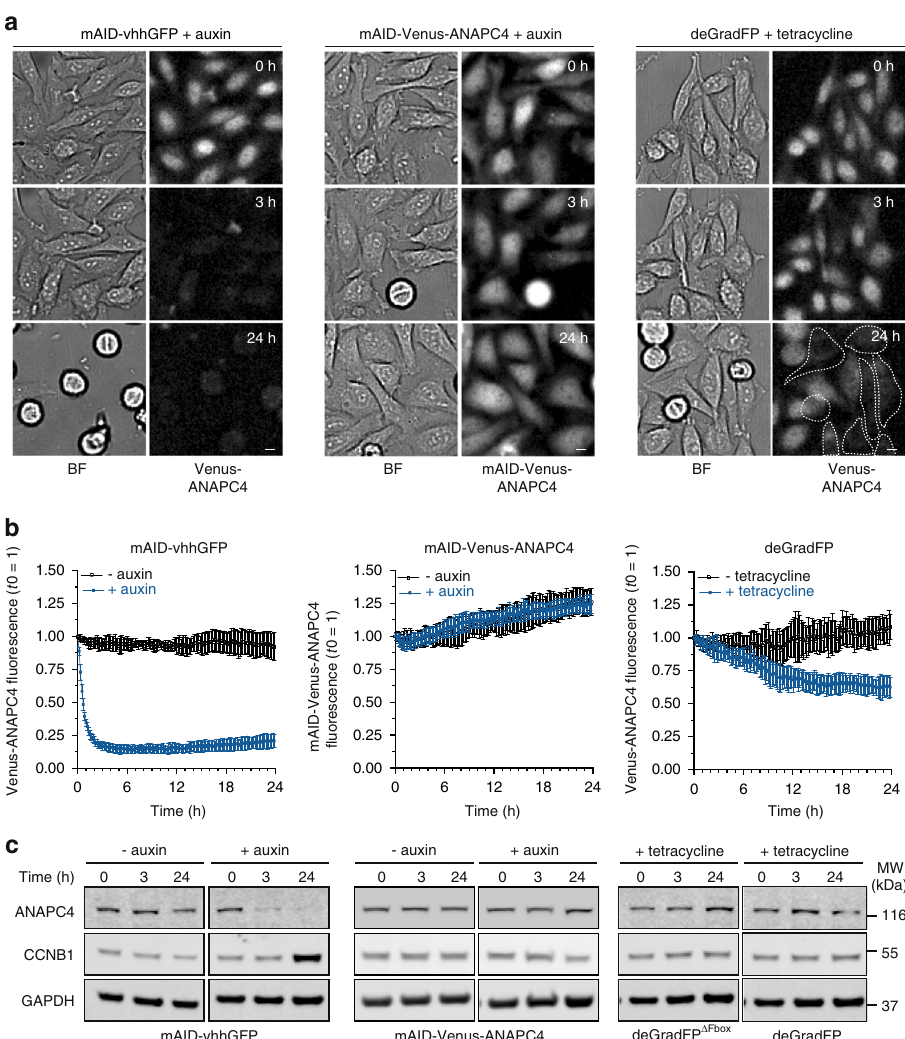
Fig. 5 Degradation of endogenous ANAPC4 by mAID-nanobodies in comparison with AID and deGradFP systems. a Time-lapse images showing the degradation of endogenously tagged Venus-ANAPC4 and mAID-Venus-ANAPC4, respectively, in response to the addition of 0.5 mM auxin for mAID- nanobodies and AID-Venus-ANAPC4 or 1 μ g/ml tetracycline to induce deGradFP expression. Cells that ef fi ciently degraded Venus-ANAPC4 during 24h of deGradFP expression are high-lighted by a dotted line. b Degradation kinetics of the time-lapse data shown in a represented as the mean ± s.d. for mAID- vhhGFP ( n = 9, − auxin; n = 16, + auxin), mAID-Venus-ANAPC4 ( n = 12, − auxin; n = 20, + auxin), and deGradFP ( n = 8, − tetracycline; n = 11 + tetracycline). c Western blot analysis of cells treated as in a for the indicated time. Increased levels of CCNB1 are indicative of a mitotic arrest and thus functional inactivation of the APC/C. See also Supplementary Figure 4 for characterization of the mAID-Venus-ANAPC4 knock-in, the effect of prolonged expression of deGradFP on Venus-ANAPC4 and CCNB1 levels, and Venus-ANAPC4 fl uorescence in response to expressing deGradFP and deGradFP Δ